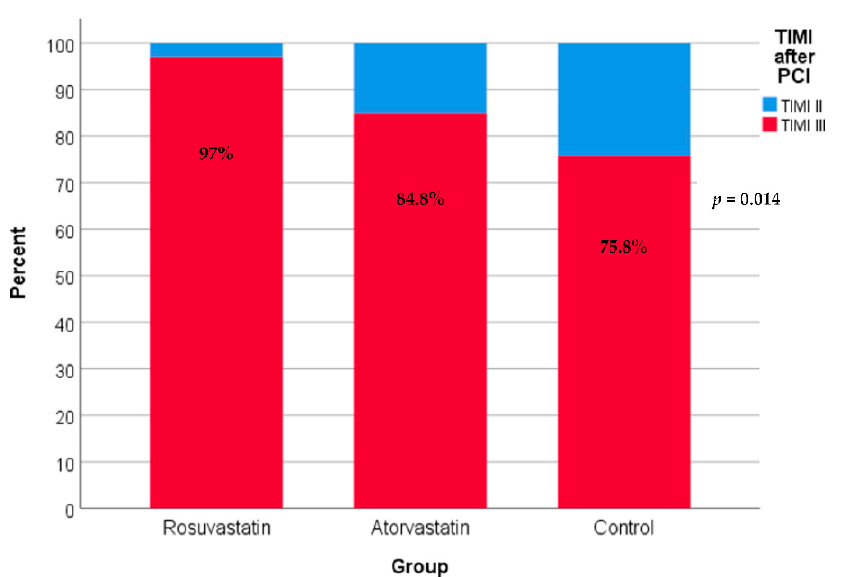
Figure 1. TIMI (thrombolysis in myocardial infarction) flow grade after PCI in the three study groups. Using the chi-square test for trend.